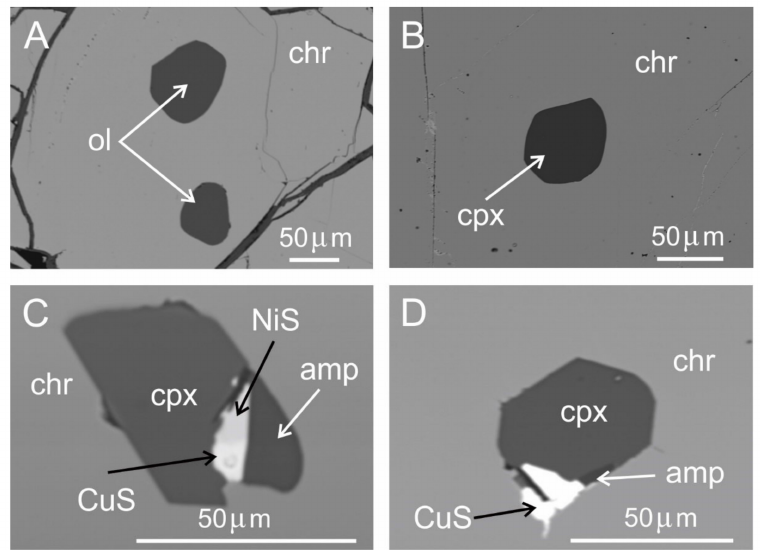
Figure 6. BSE images of mafic-silicate inclusions in chromite of the Kraka deposits. Polygonal and rounded olivine, sample PE1758 ( A ); subrounded clinopyroxene, sample PE1757 ( B ); composite inclusions of clinopyroxene and amphibole associated with Ni and Cu sulfides, sample PE1757b2 ( C ) and sample PE1757b5 ( D ). Abbreviations: Chr = chromite; Ol = olivine; Cpx = clinopyroxene; Am = amphibole; NiS = Ni sulfide; CuS = Cu sulfide. The dark lamellar silicate associated with the sulfides in picture ( C , D ) is chlorite.